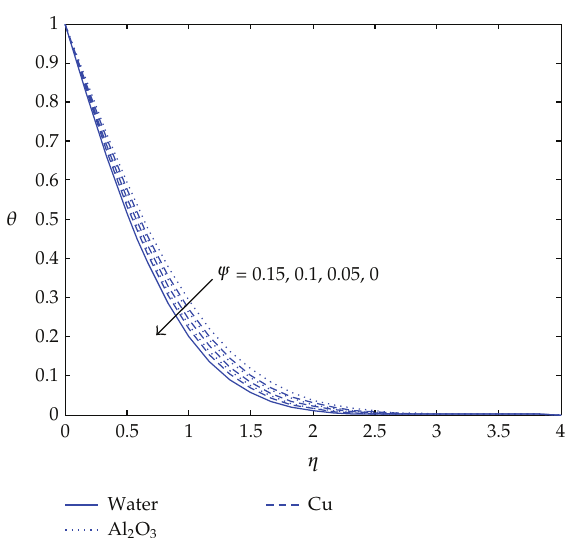
Figure 2: Variation of dimensionless temperature for di ff erent values of ψ (cid:5) Pr (cid:8) 6 . 2, m (cid:8) 1, p (cid:8) 1 , ξ (cid:8) 0 . 1, ∧ (cid:8) 0 . 1 (cid:6) .